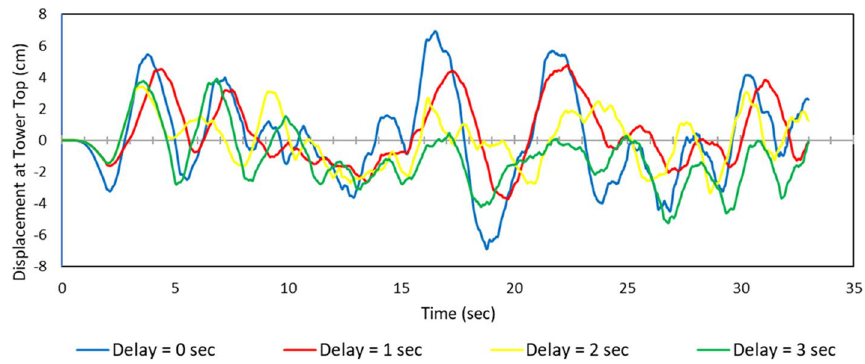
Fig. 14 Time history of displacement of LHS‑tower top point under Tabas